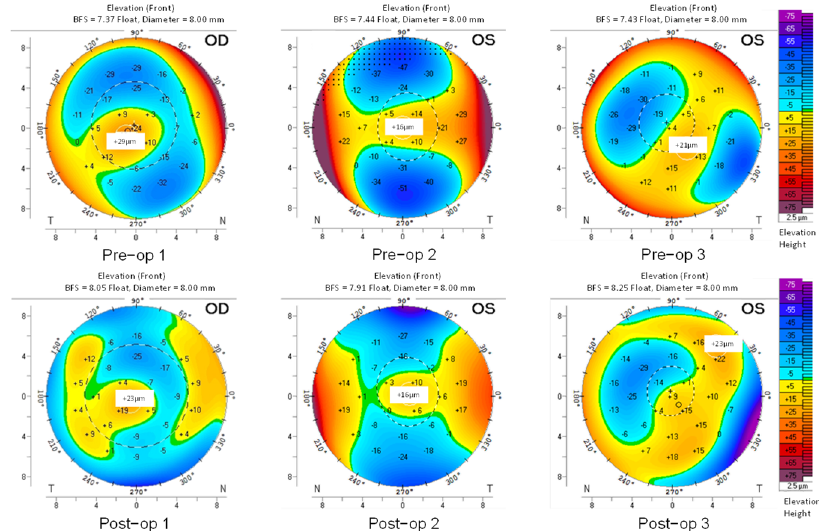
Figure 1. ELE ‐ front maps based on Pentacam ‐ derived topometric data for the three representatives of the KCN group before (pre ‐ op) and after (post ‐ op) the intracorneal implantation within 8 mm diameter of the cornea (the horizontal and the vertical axis). The color ‐ coded scale is identical in all images. Figure 2 shows the color-coded maps of ELE-back of healthy and KCN subjects, respectively.